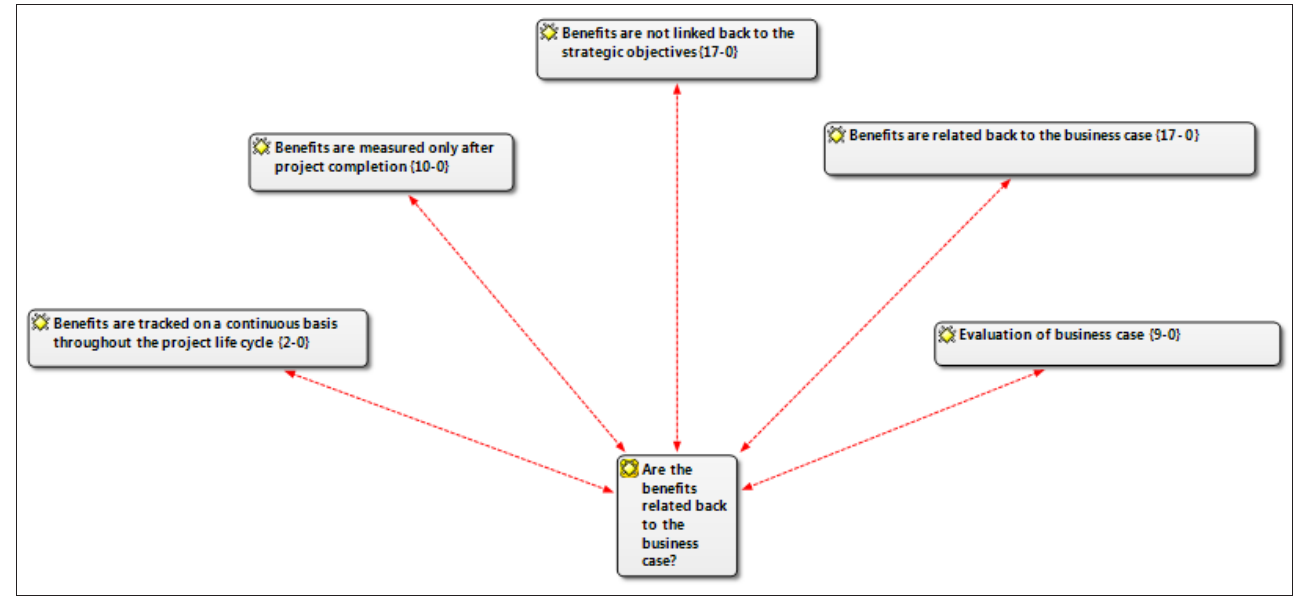
FIGURE 6: Network view: Inductive codes reflecting whether benefits are related back to the business